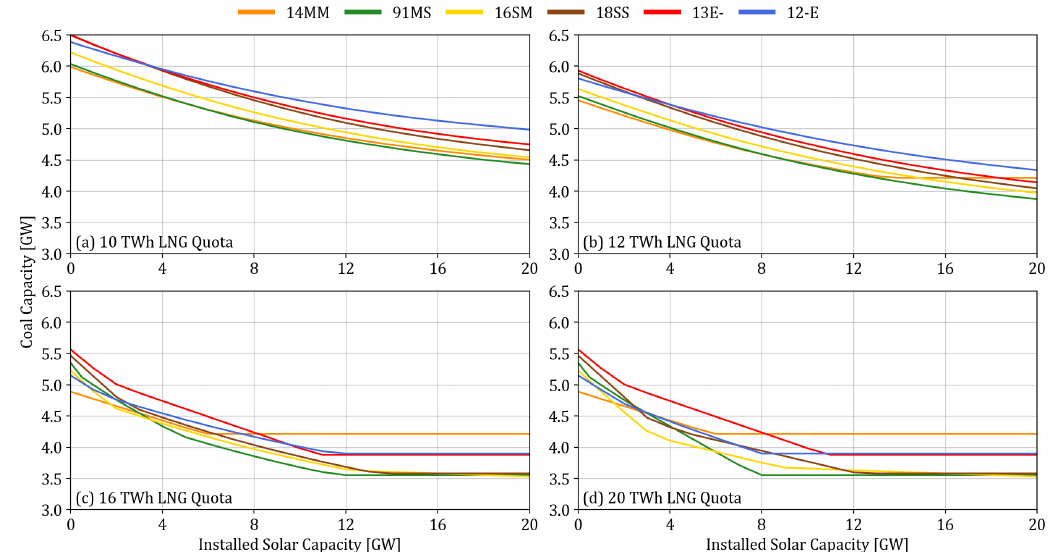
Figure 11. Minimum required coal capacity as installed solar capacity increases, and various LNG quotas.